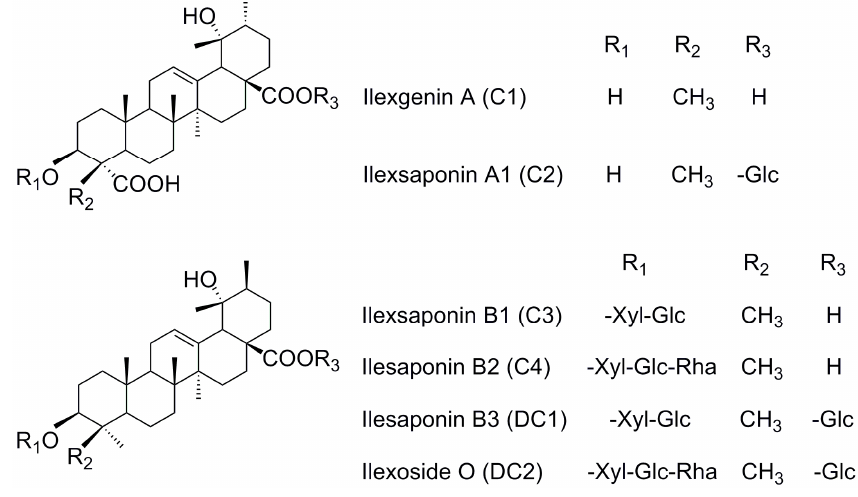
Figure 1. Chemical structures of IlexgeninA (C1), Ilexsaponin A1 (C2), Ilexsaponin B1 (C3), Ilesaponin B2 (C4), Ilesaponin B3 (DC1) and Ilexoside O (DC2).